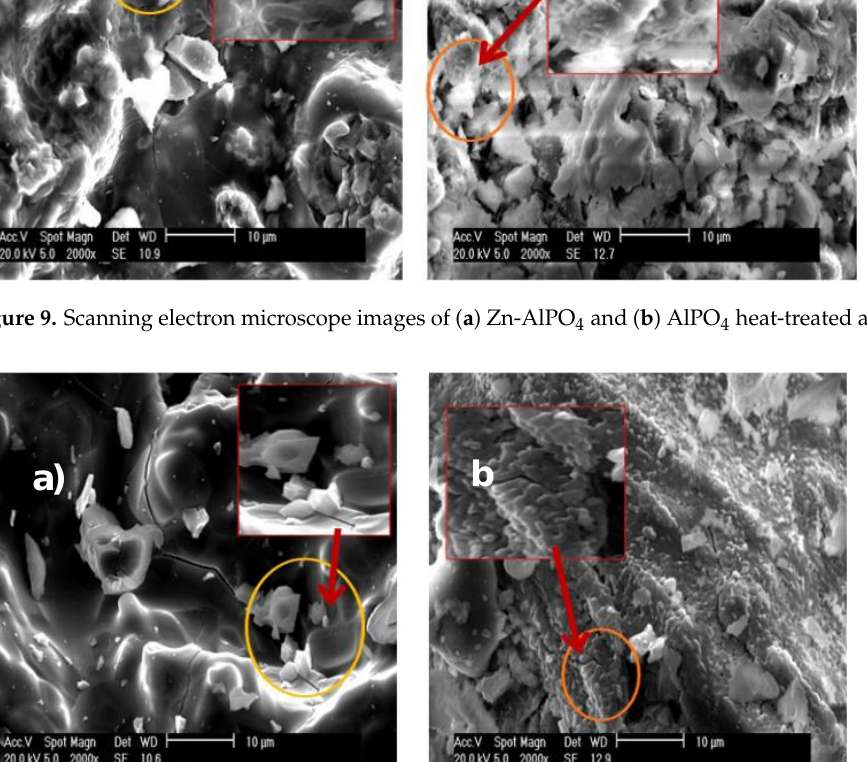
Figure 10. Scanning electron microscopies of ( a ) Zn-AlPO 4 and ( b ) AlPO 4 heat-treated at 1000 °C.